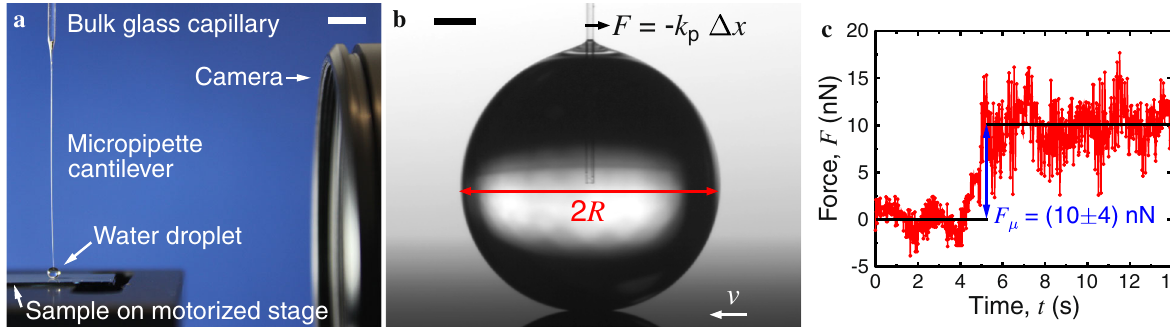
Fig. 2 Micropipette force sensor measurements of the friction of water droplets moving on superhydrophobic surfaces. a Photograph of the MFS setup with a millimetric water droplet on a superhydrophobic surface. The droplet is attached through capillary forces to a force-calibrated micropipette cantilever (pulled from a 1 mm thick glass capillary). The experiment is recorded with a camera from the side. Scale bar 5 mm. b Photograph of water droplet (radius R ¼ 620 ± 8 μ m, contact region diameter D ¼ 210 ± 20 μ m) on the spikes surface (sample A). During the experiment (see Supplementary Movie 1), the droplet is initially pulled along the substrate (resting on a motorized xyz -translational stage that starts moving to the left at time ~5 s with a constant speed of v ¼ 0 : 1 mm s − 1 ) until the elastic force ( F ¼ (cid:3) k p Δ x , where k p is the spring constant of the pipette obtained through calibration) from the de fl ected ( Δ x ) micropipette matches the kinetic friction force ( F μ ) of the substrate. At this point, the micropipette de fl ection remains nearly constant while the droplet slides along the surface. Scale bar 200 μ m. c Force as a function of time from a typical experiment (same as in b ). The average equilibrium (zero-force) position of the micropipette was fi rst recorded for ~5 s after which the surface started moving. The difference between the average zero and kinetic plateau force gives the kinetic friction force ( F μ ). The error includes the standard deviation of both